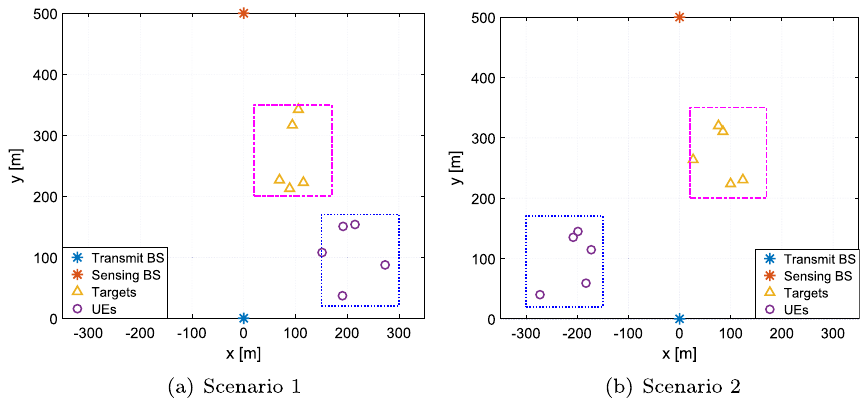
Fig. 2 Two scenarios of different network typologies